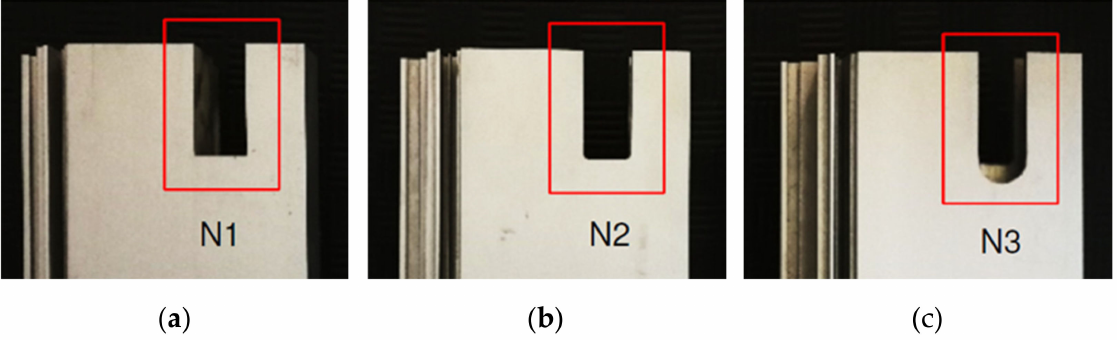
Figure 4. Shape of root notch: ( a ) sharp, N1, ( b ) rounded, N2, ( c ) semi-circular, N3.